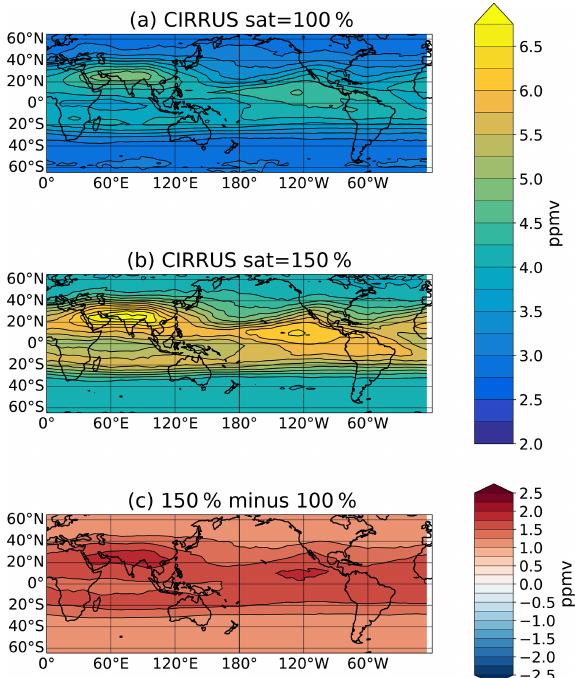
Figure 3. Distribution of water vapour at 100hPa of CIRRUS us- ing (a) 100% and (b) 150% as the saturation mixing ratio with respect to ice during boreal summer for 2005–2010 and (c) their